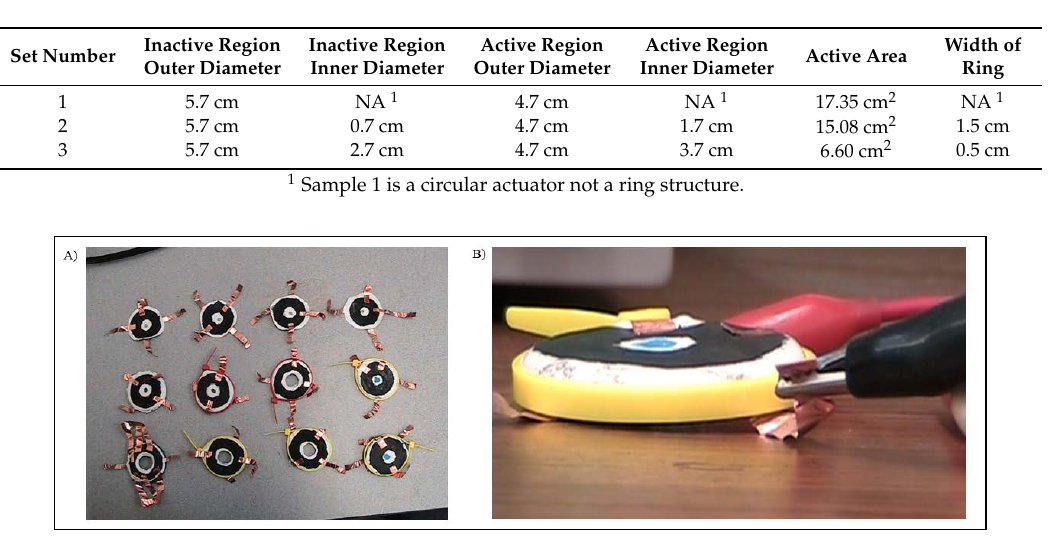
Figure 1. ( A ) Image of Standard Constructed Actuators. ( B ) Image of Powered Actuator [23,24].